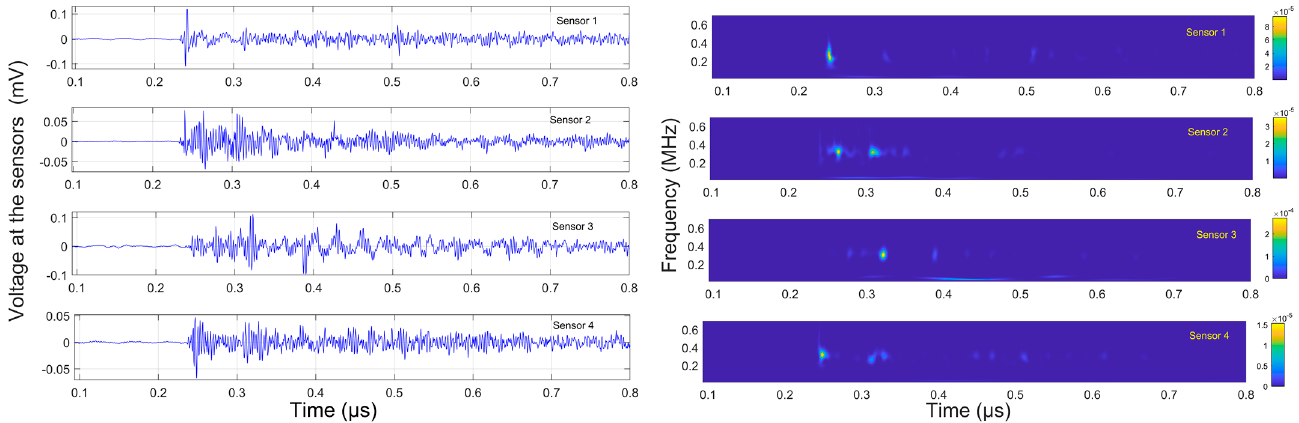
Figure 11. Time domain signals and their CWT characteristics corresponding to the same AE event as detected by the four AE sensors at the end of the first stage (t = 201,84 s).